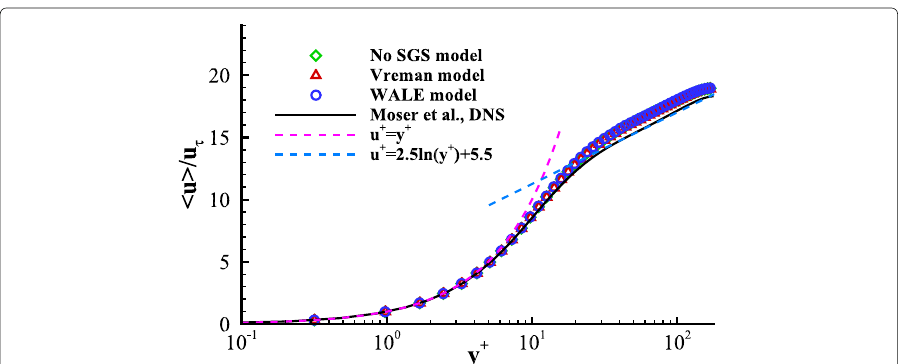
Fig. 3 The computed mean velocity profile with wall-layer scaling laws in inner wall coordinates for the fully developed turbulent channel flow